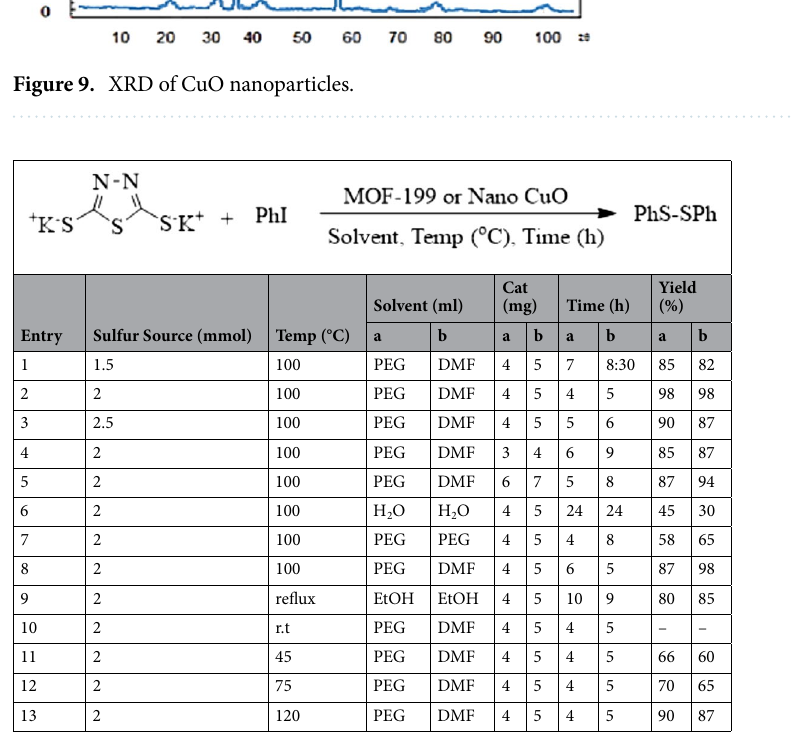
Table 1. Optimization of the reaction conditions a . a: Reaction conditions: iodobenzene (1